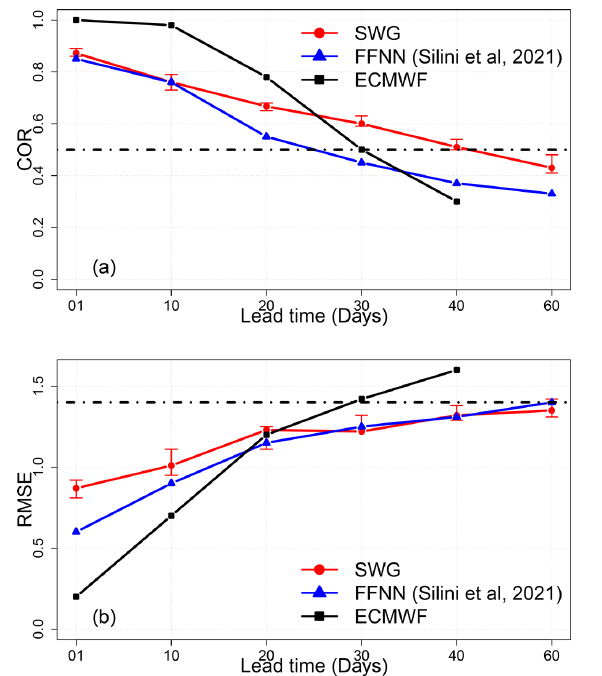
Figure 12. Comparison of the values of COR (a) and RMSE (b) be- tween the SWG forecast and forecasts of Silini et al. (2021) (blue lines) and the ECMWF (black lines). Confidence intervals for SWG (red lines) were obtained with a bootstrap procedure over the simu- lations (1000